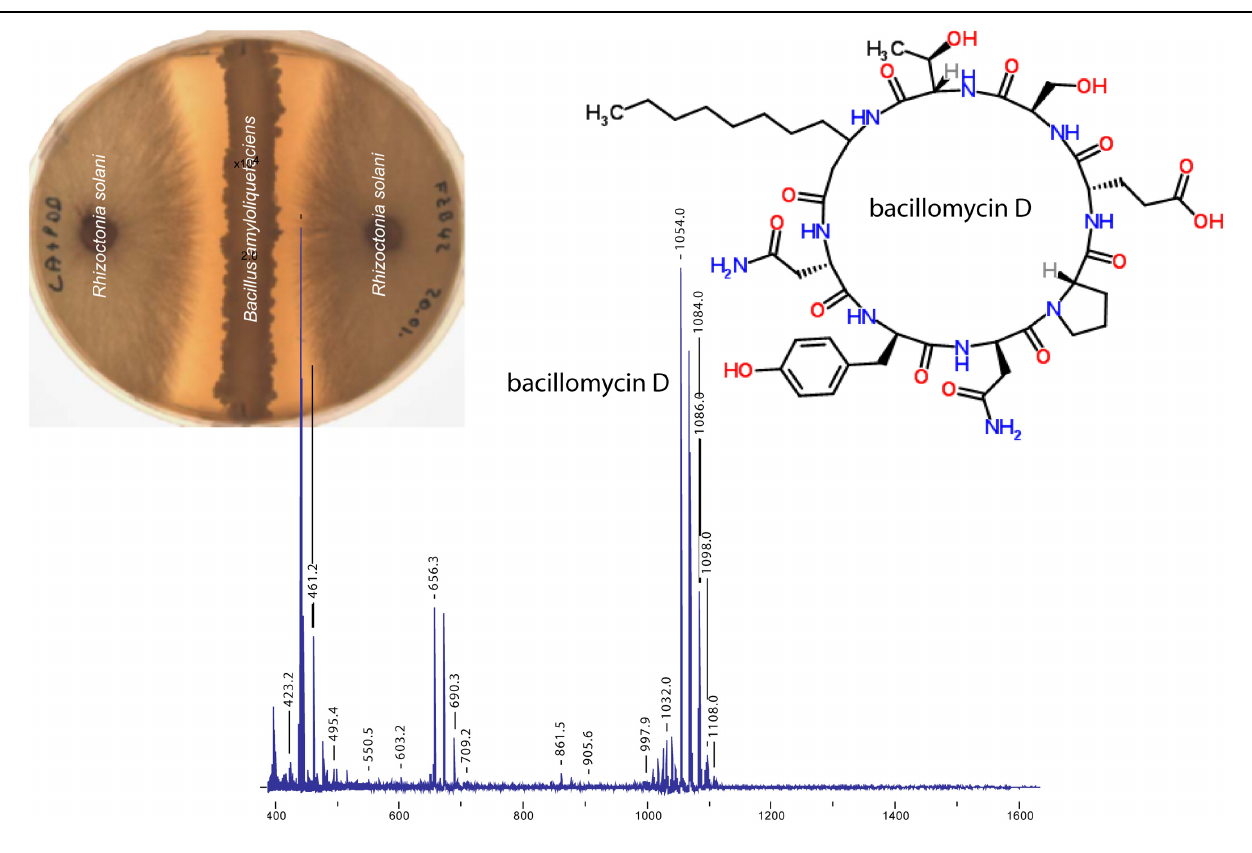
FIGURE 2 | Effect of FZB42 on Rhizoctonia solani. A clear inhibition zone indicating growth suppression of the fungal pathogen is visible on agar plates simultaneously inoculated with both microbes. Bacillomycin D was detected as the only prominent compound by Matrix-Assisted Laser